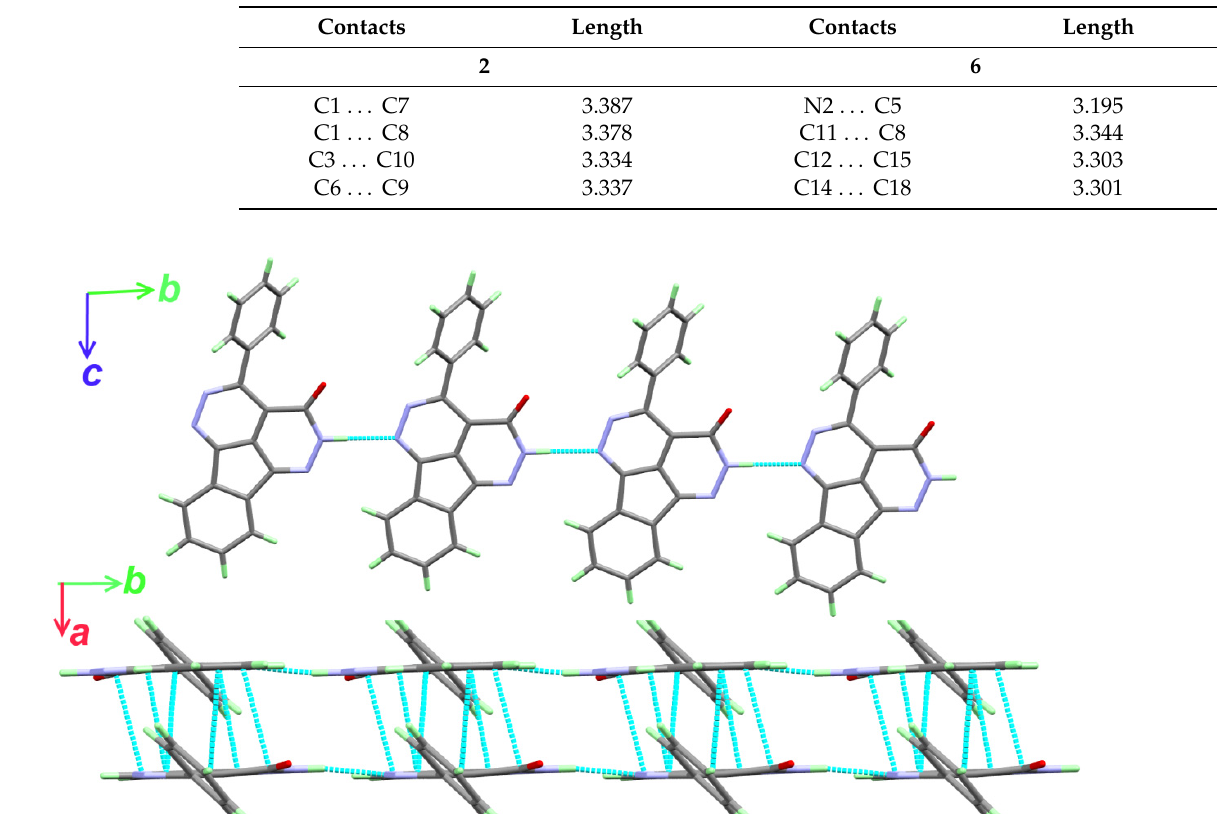
Table 4. π – π stacking for 2 and 6 [Å and °].